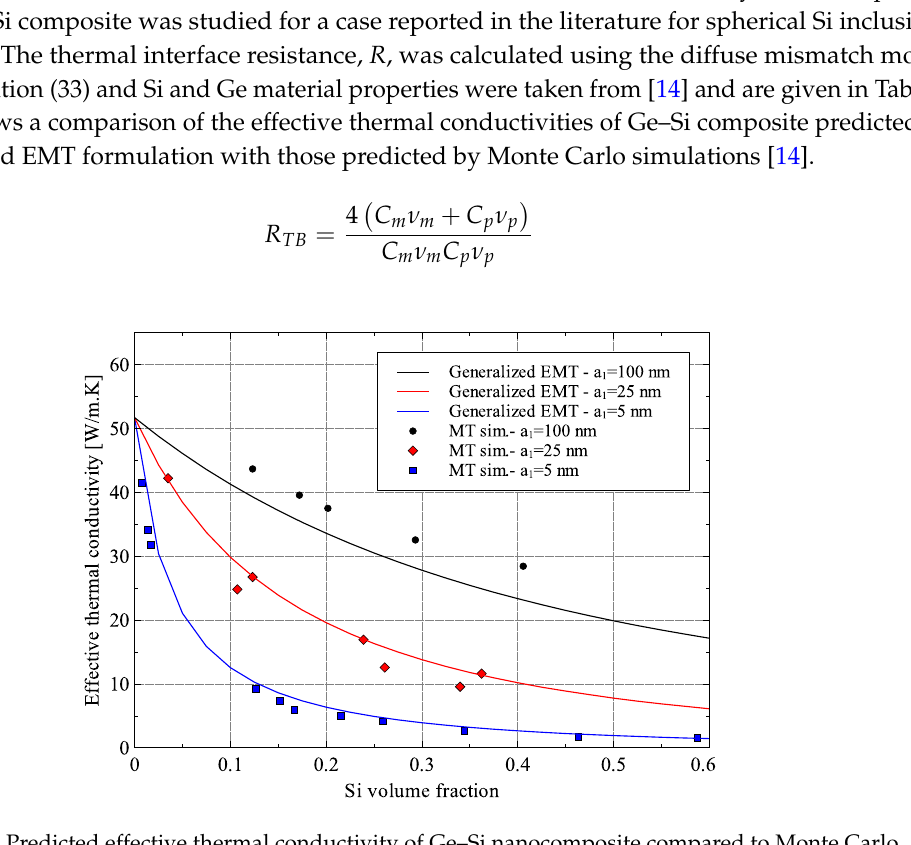
Figure 12. Predicted effective thermal conductivity of Ge–Si nanocomposite compared to Monte Carlo (MT) simulations [18] ( R TB = 6.80 × 10 − 9 m 2 ·K/W). (MT) simulations [18] ( R × 10 − 9 m 2 · TB = 6.80